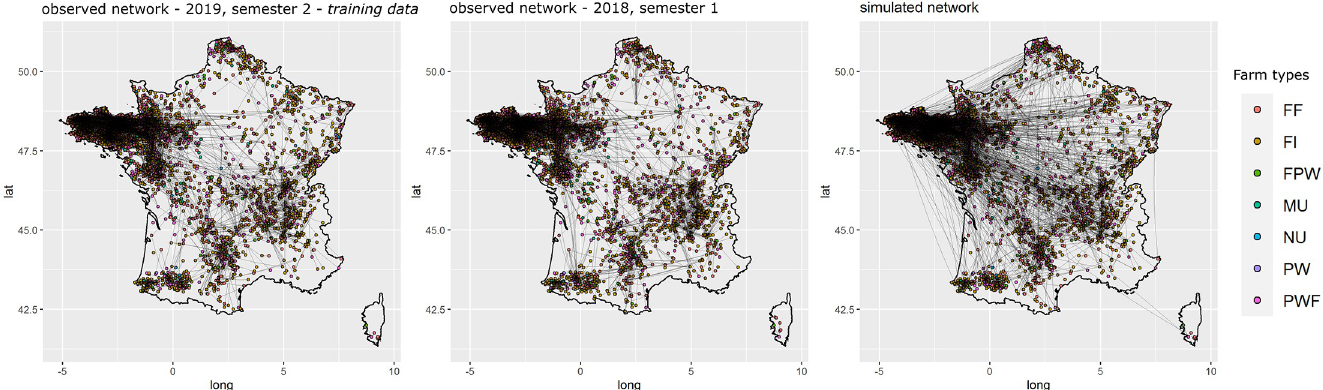
Fig 10. Maps of observed and simulated networks for pigs. Mapping of semestrial networks drawn by the transport of growing pigs. The network on the left was observed during the second semester of 2019, those data were used to fit the model, the network in the center was observed during the first semester of 2018, and the one on the right was simulated using the fitted exponential random graph